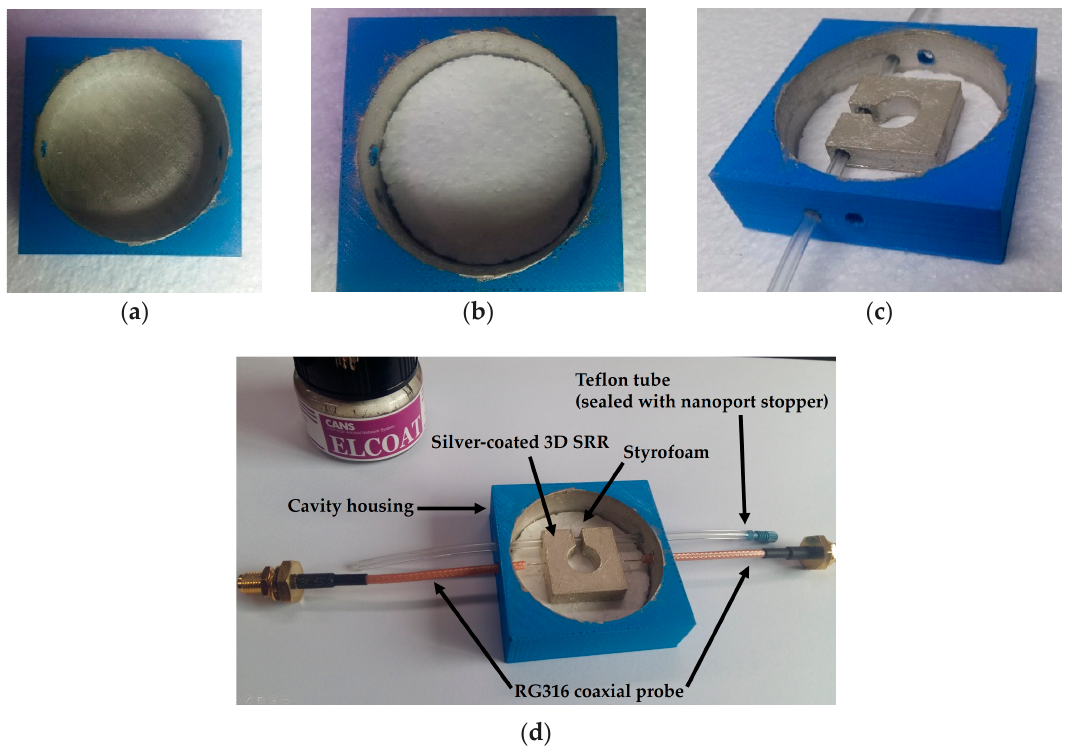
Figure 8. Stepwise fabrication of the silver-coated 3D-printed SRR residing in a cavity housing and capacitively coupled through two coaxial cables (RG316): ( a ) Cavity housing with silver-coated inside walls and base, ( b ) Styrofoam as a base plate in the cavity housing, ( c ) silver-coated SRR along with a Teflon tube passing through it and centered on the Styrofoam, and ( d ) complete assembly of our proposed structure ready for measurements.